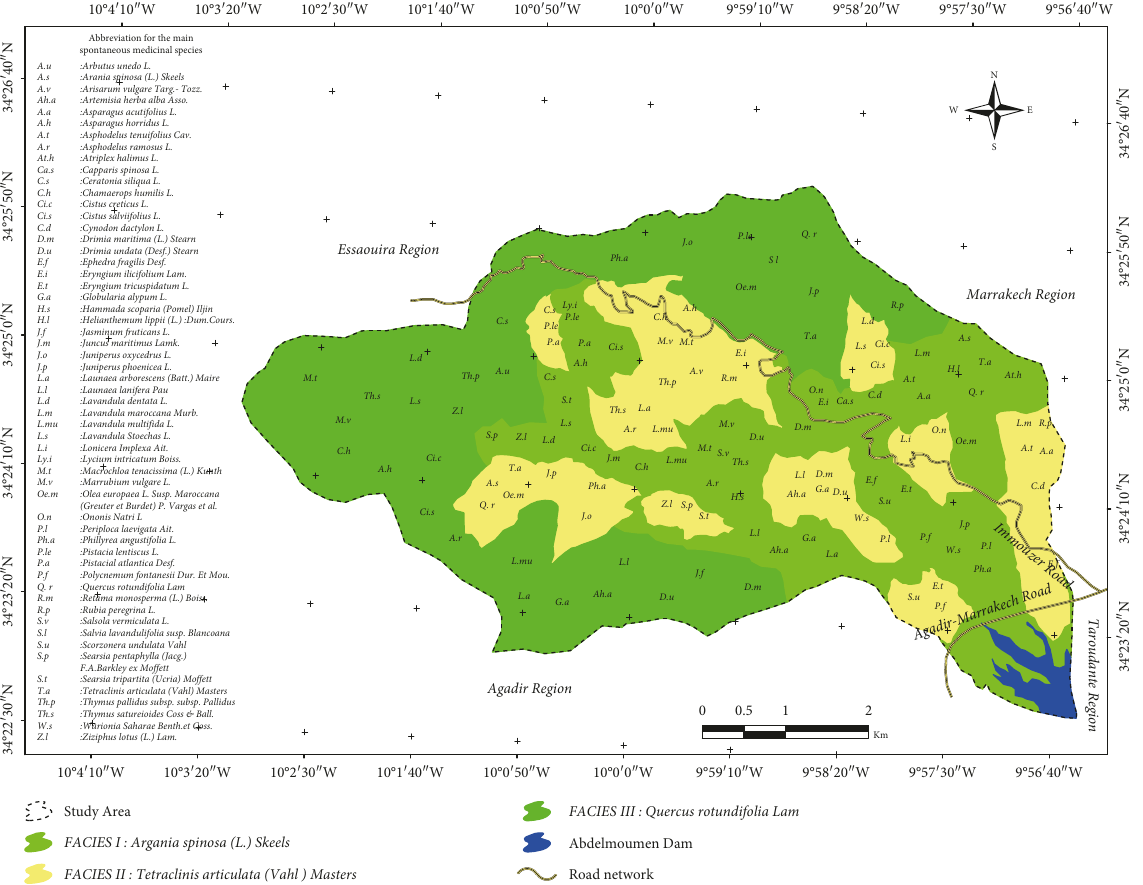
:Searsia pentaphylla (Jacg.) F.A.Barkley ex Moffett S.t :Searsia tripartita (Ucria) Moffett T.a :Tetraclinis articulata (Vahl) Masters Th.p :Thymus pallidus subsp. subsp. Pallidus Th.s :Thymus satureioides Coss & Ball. W.s :Warionia Saharae Benth.et Coss. Z.l :Ziziphus lotus (L.) Lam. Study Area FACIES I : Argania spinosa (L.) Skeels FACIES II : Tetraclinis articulata (Vahl ) Masters Figure 7: Map showing the distribution of the main spontaneous species medicinal and aromatic properties by facies in the region